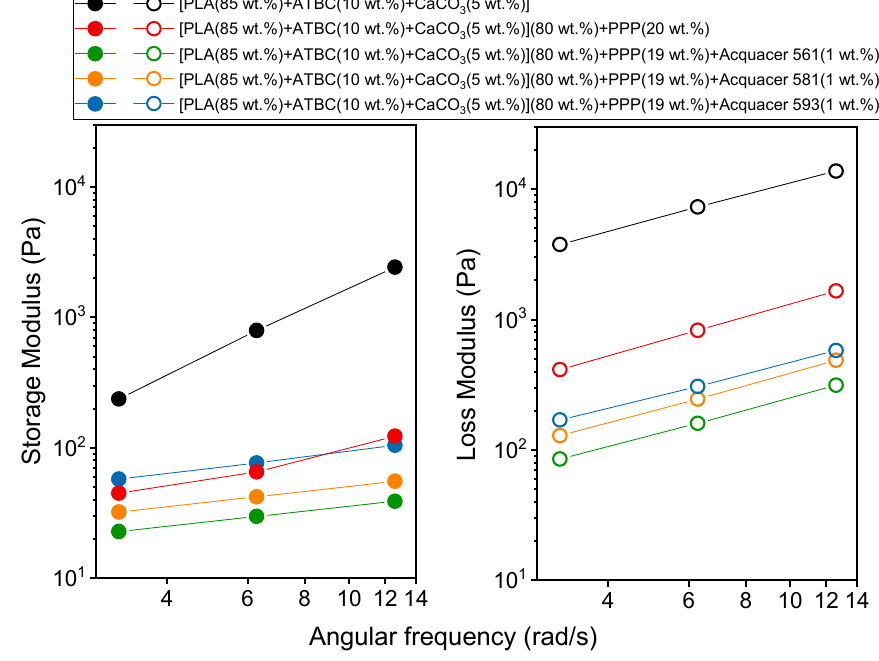
Figure 5. Storage and loss moduli (G (cid:48) and G”, respectively) vs. angular frequency ( ω ) at 175 ◦ C for the PLA based matrix and biocomposites indicated in the legend. The solid lines are a guide to the eye.